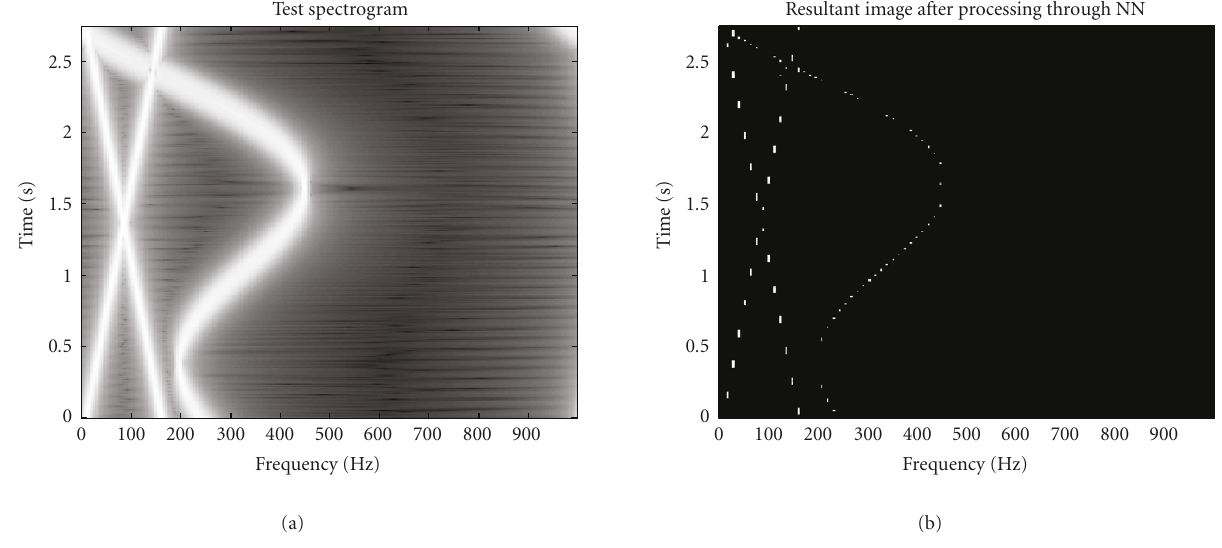
Figure 4: TFDs of a synthetic signal consisting of crossing chirps and a sinusoidal FM component. (a) Spectrogram (TI 4) [Hamm, L = 90], and (b) NTFD.